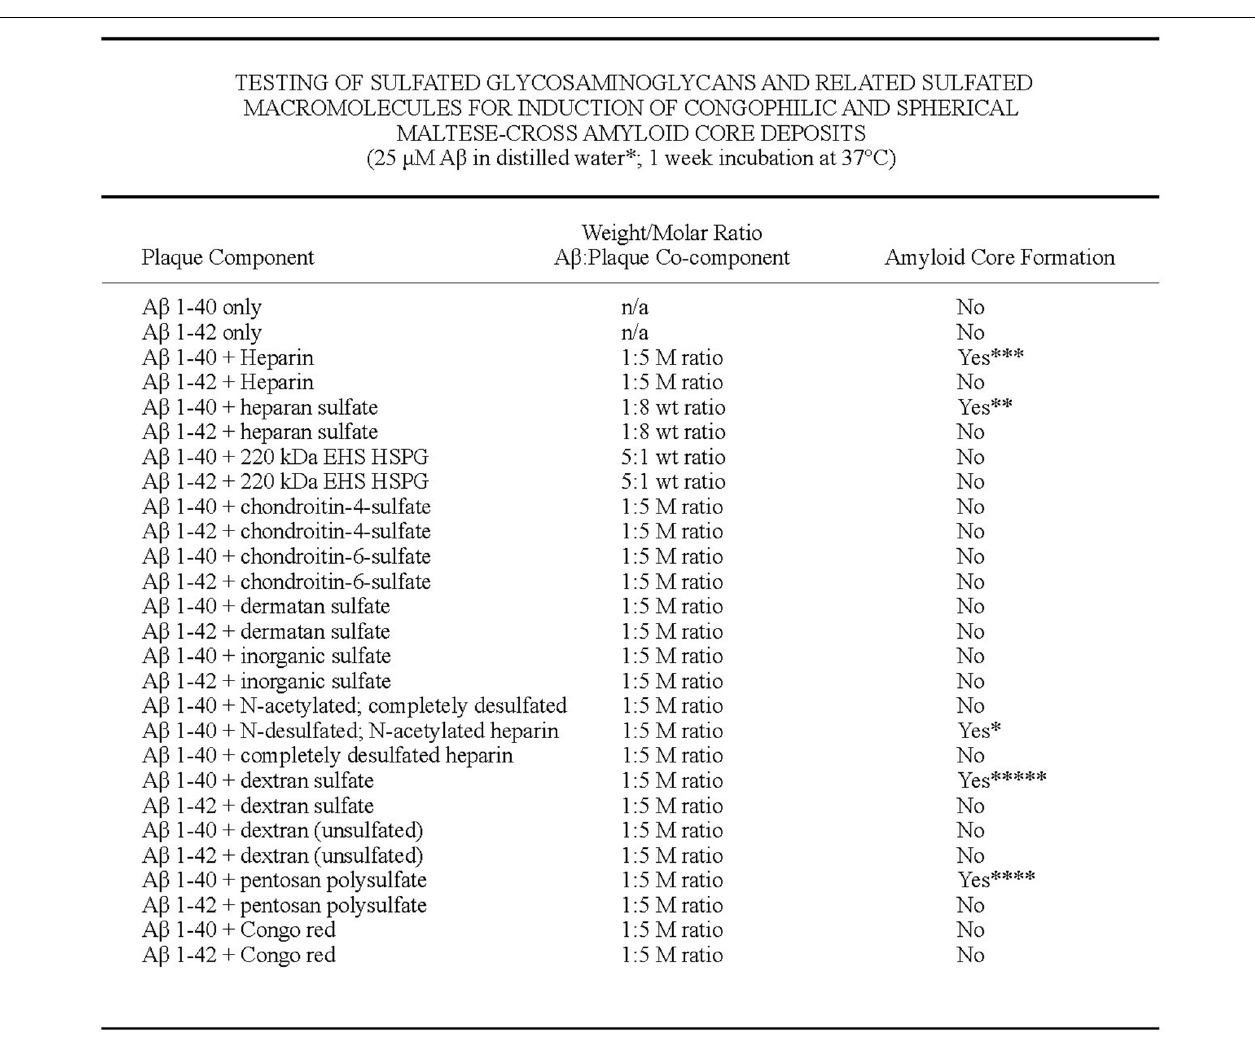
FIGURE 7 | Testing of sulfated GAGs and related sulfated macromolecules for induction of congophilic and spherical maltese-cross amyloid core deposits. A β 1–40 and A β 1–42 in the absence of the presence of different sulfated GAGs and related macromolecules were tested to induce congophilic spherical maltese-cross amyloid core deposits as those found in AD brain. Only highly sulfated GAGs and related macromolecules including heparin, heparan sulfate, dextran sulfate, pentosan polysulfate, and perlecan (isolated from Engelbreth-Holm-Swarm sarcoma) induced A β 1–40 (but not A β 1–42) to form congophilic spherical maltese-cross amyloid core deposits identical to those seen in the human AD brain. The preferred molar: ratio of A β :sulfated GAG ratio was about 1:5 (with A β 1–40 at 25 µ M). On the other hand, the preferred weight ratio of A β : heparan sulfate for congophilic maltese-cross amyloid plaque formation was 1:8 (i.e., 50 µ g A β 1–40 in 100 µ l of distilled water with 400 µ g of heparan sulfate). Congophilic maltese-cross amyloid core formation under the same molar ratios were not observed for chondroitin-4-sulfate, chondroitin-6-sulfate, dermatan sulfate, inorganic sulfate, N-acetylated completely desulfated heparin, and unsulfated dextran indicating that highly sulfated GAGs and related macromolecules were primarily needed for induction of amyloid plaque core formation. Only A β 1–40, but not A β 1–42 induced amyloid plaque core formation with highly sulfated GAGs, perlecan and highly sulfated macromolecules [(including dextran sulfate, pentosan polysulfate, and polyvinyl sulphonate (Castillo and Snow, 2006). Amyloid plaque core formation was scored blindly according to the number of plaque cores observed in a 5 µ l aliquot ( ∗ 1–5 cores, ∗∗ 5–10 cores, ∗∗∗ 10–30 cores, ∗∗∗∗ 30–50 cores, ∗∗∗∗∗ 50